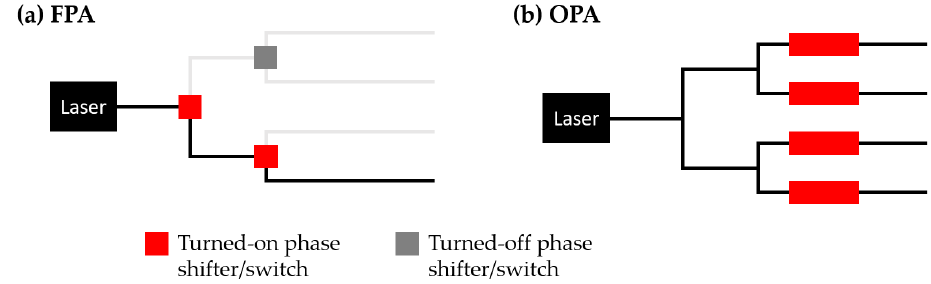
Figure 5. Comparison of the electric power consumption between the focal plane array ( a ), and the optical phased array ( b